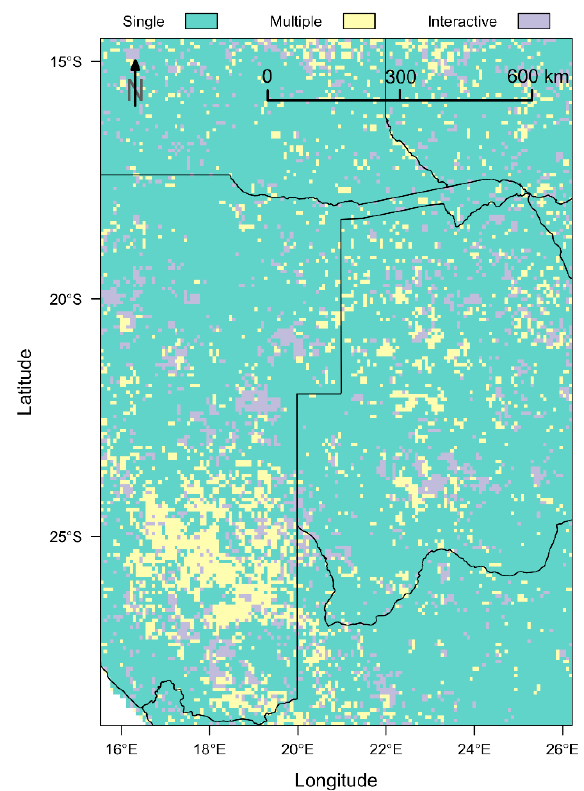
Figure D1. Maps of the South West African (SWA) study region of the mode of the shifting linear regression model (SLR) with the lowest AIC. “Single” = model with only rainfall of concurrent year as explanatory variable, “Multiple” = model with rainfall of concurrent year and previous year as additive variables and “Interactive” = model with an added interaction term of the “Multiple” model.